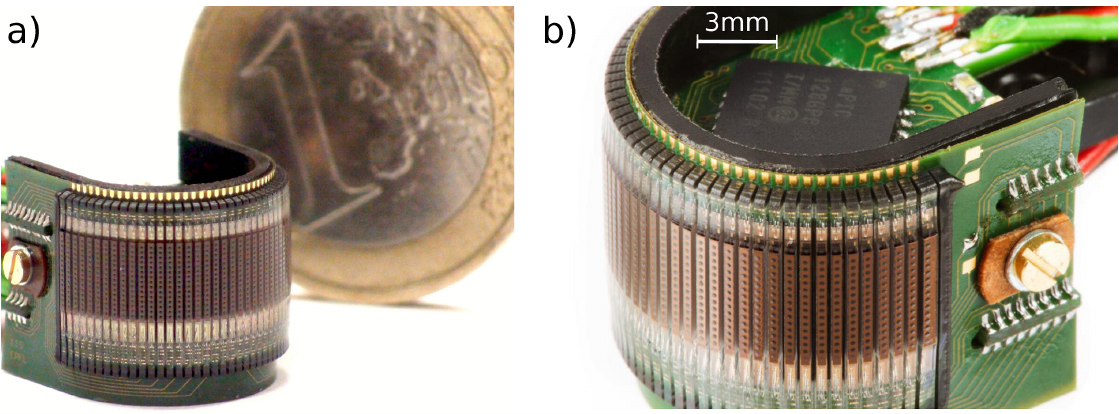
Figure 1. ( a ) Image of the curved artificial compound eye (CurvACE) sensor, which has a radius of curvature of only 6.35 mm, a mass of only 1.75 g and a power consumption of 0.9 W. The cylindrical shape of the eye was obtained by bending a rectangular array consisting of 42 columns of 15 artificial ommatidia (microlens diameter = 172 µm ).